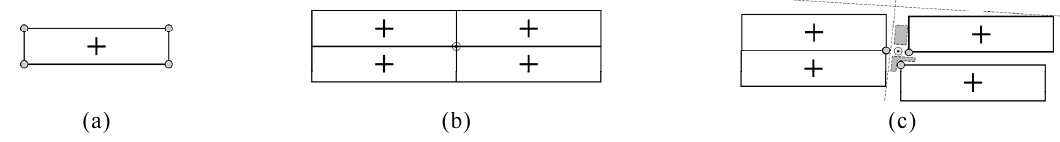
Figure 8. Schematic diagram of the generated candidate label positions. ( a ) Four reference points; ( b ) the generated candidate label positions without obstacle; ( c ) the generated candidate label positions with line and area obstacles.